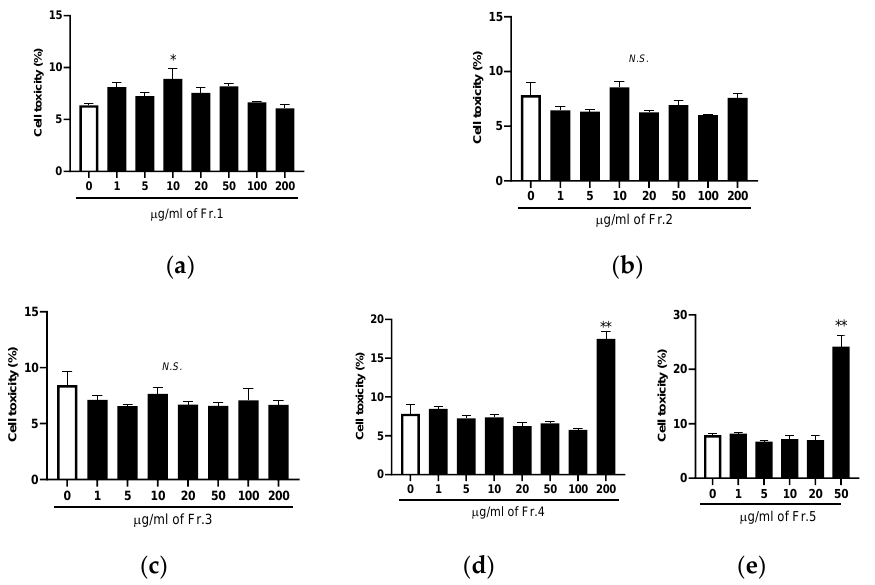
Figure 4. Effects of five turmeric extract (TE) fractions on cell cytotoxicity in C2C12 myotubes. ( a – e ) Different concentrations of Fr.1, Fr.2, Fr.3, Fr.4, and Fr.5 were added to C2C12 myotubes for 12 h, after which lactate dehydrogenase assay was performed. The results are shown as the mean ± standard error ( n = 4), and statistical analysis was performed by Tukey – Kramer test. * p < 0.05, ** p < 0.01 vs. 0 µg/mL, N.S.: not significant.